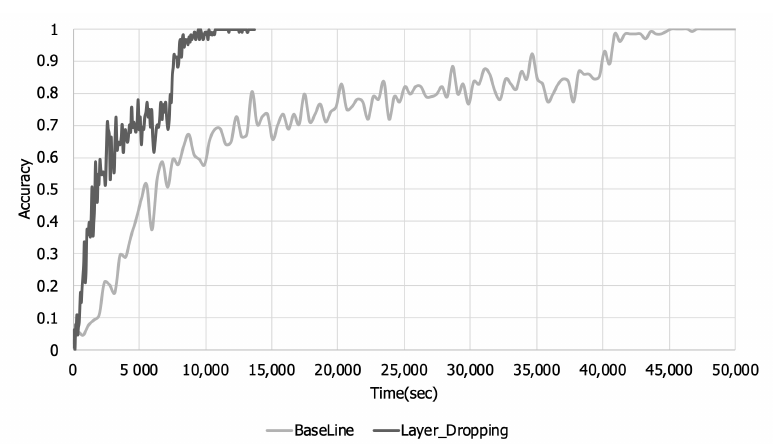
Figure 7. Training loss over time in a low bandwidth network.